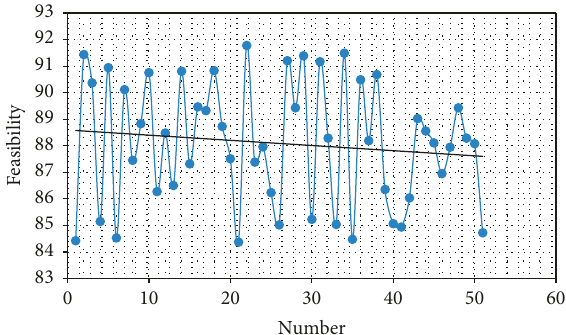
Figure 7: Statistical diagram of planning feasibility.